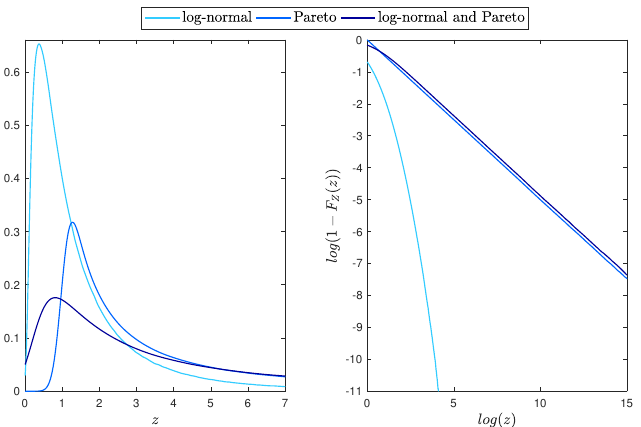
Figure 4. Distribution of the product of two independent random variables from the log-normal and Pareto distribution with µ X = 0 and σ X = θ Y = 1 and different values of a Y parameter. ( Left panel ): the PDF of the random variable Z . ( Right panel) : the distribution tail for the random variable Z (in log-log scale).